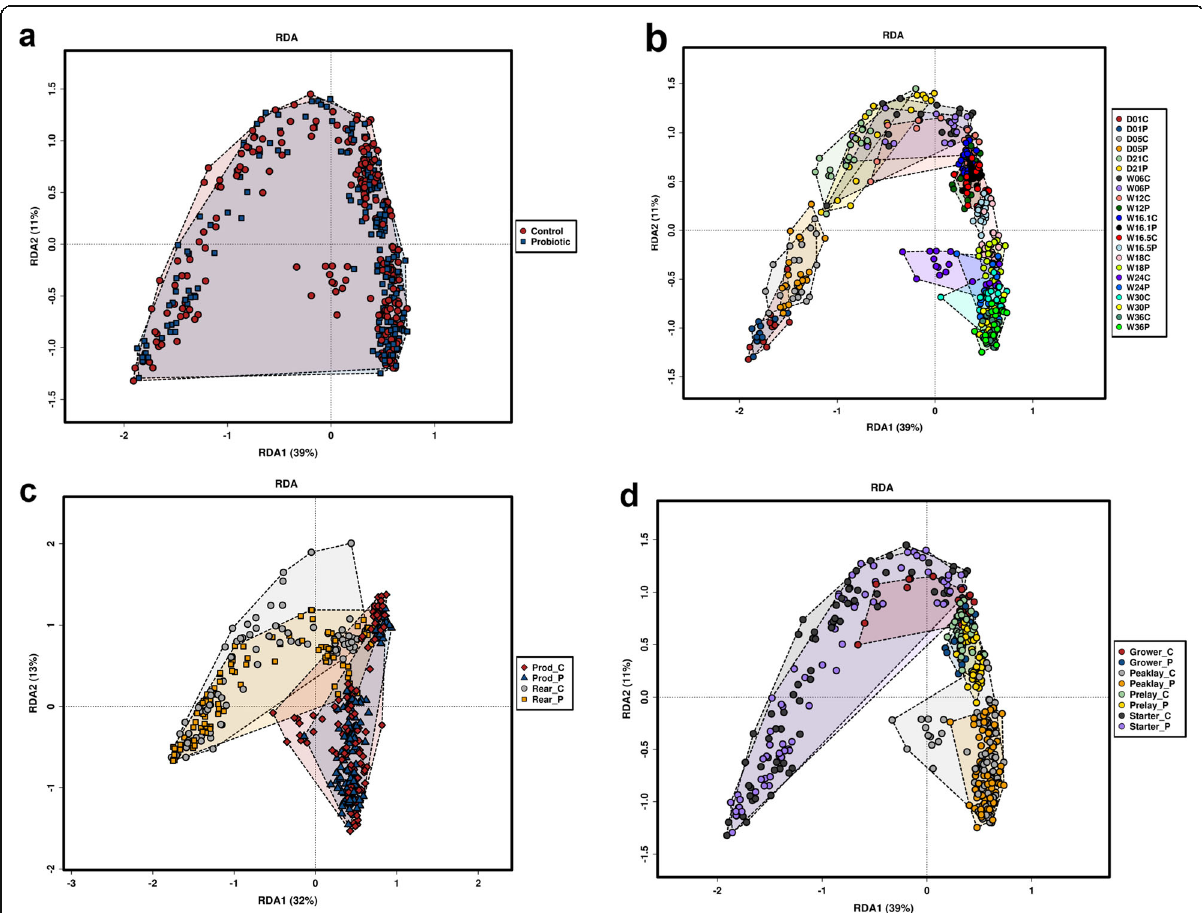
Fig. 8 Genus level redundancy analysis showing gut microbiota composition affected by probiotic supplementation and flock arearing conditions. a). Overall community composition of gut microbiota between probiotic supplemented and control flocks. b). Community composition of gut microbiota affected by flock age and probiotic supplementation. c). Community composition of gut microbiota when the birds were sampled from a rearing (Rear) and production (Prod) farms. d). Community composition of gut microbiota affected by diet regimen. Within each treatment group, “ C ” refers to control, while “ P ” refers to the probiotic supplemented flocks. As per feed management guidelines of Hy-Line International, a different type of feed was introduced at week 1 (starter), week 7 (grower), week 13 (developer), week 15 (pre lay) and week 18 (peak lay) of flock